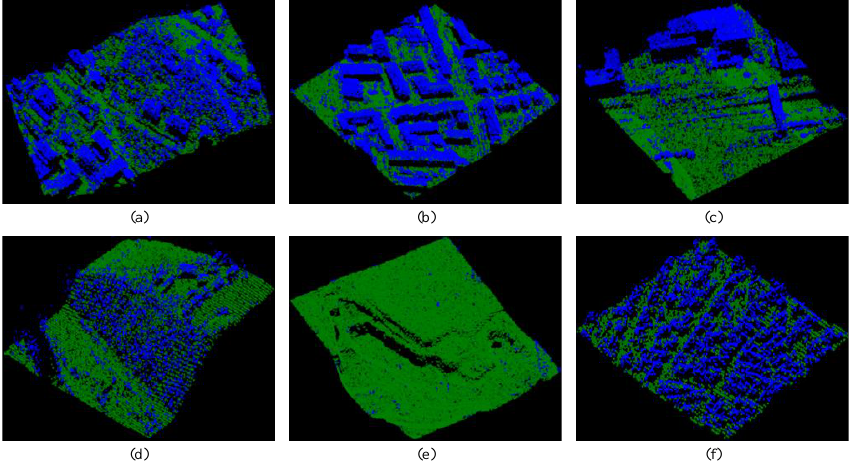
Figure 6. Several samples of the ISPRS dataset. ( a ) Samp11; ( b ) Samp12; ( c ) Samp22; ( d ) Samp51; ( e ) Samp53; ( f ) Samp54. The green dot represents the real ground point and the blue dot indicates the real non-ground point.